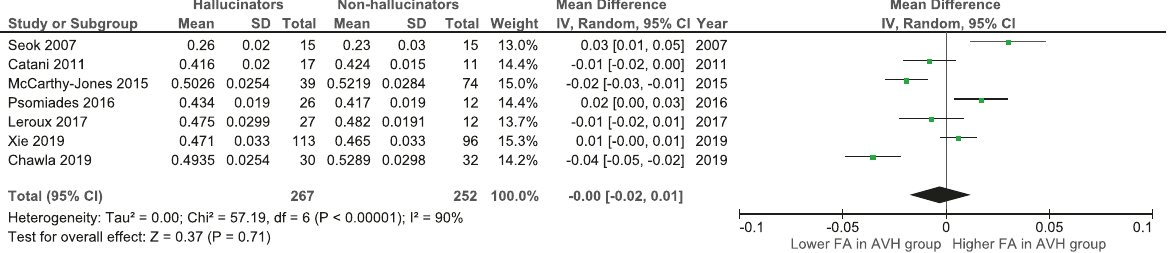
Fig. 4 A forest plot showing no signi fi cant difference between hallucinators and non-hallucinators for the fractional anisotropy of the left arcuate fasciculus. SD standard deviation, IV inverse variance, CI con fi dence interval, FA fractional anisotropy.